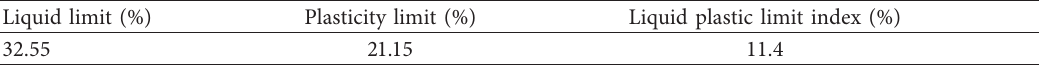
Table 1: Basic parameters of silty clay.